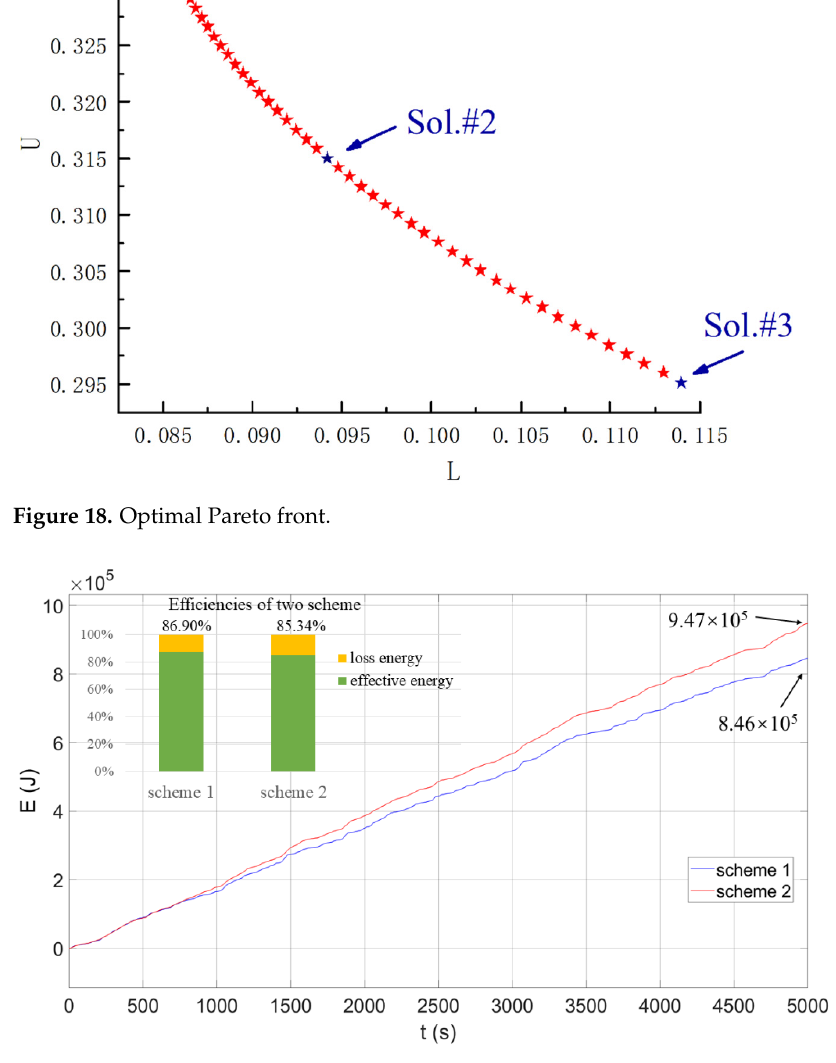
Figure 19. Comparison of energy loss. Table 2. The solution point of the Pareto front.